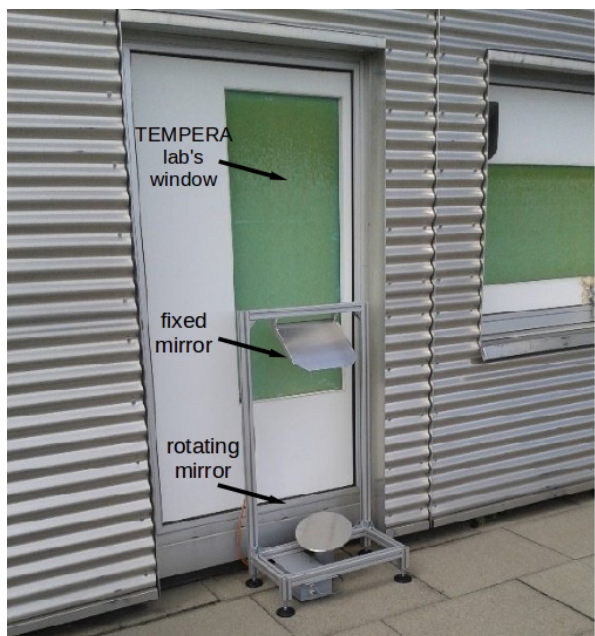
Figure 3. Secondary mirror installed on the roof of the ExWi build- ing at the University of